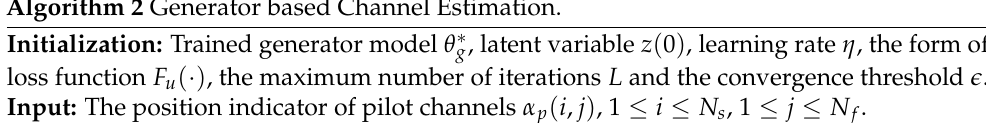
Figure 5. Procedure of recovering data channels with trained generator. Algorithm 2 Generator based Channel